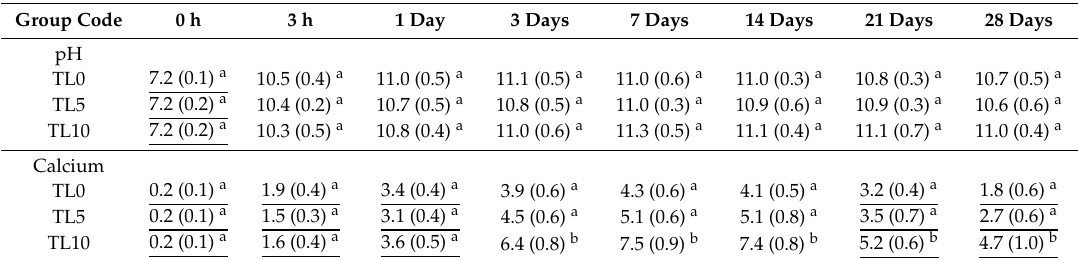
Table 3. pH of the soaking water and calcium ion release (ppm) in the soaking water (means (standard deviations), n = 6 /